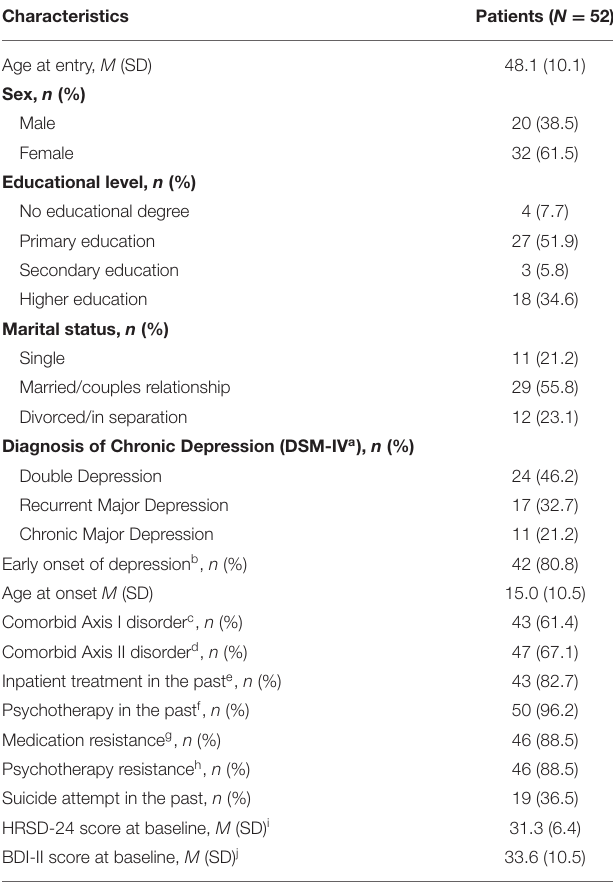
TABLE 1 | Sociodemographic characteristics of the sample ( N = 52).